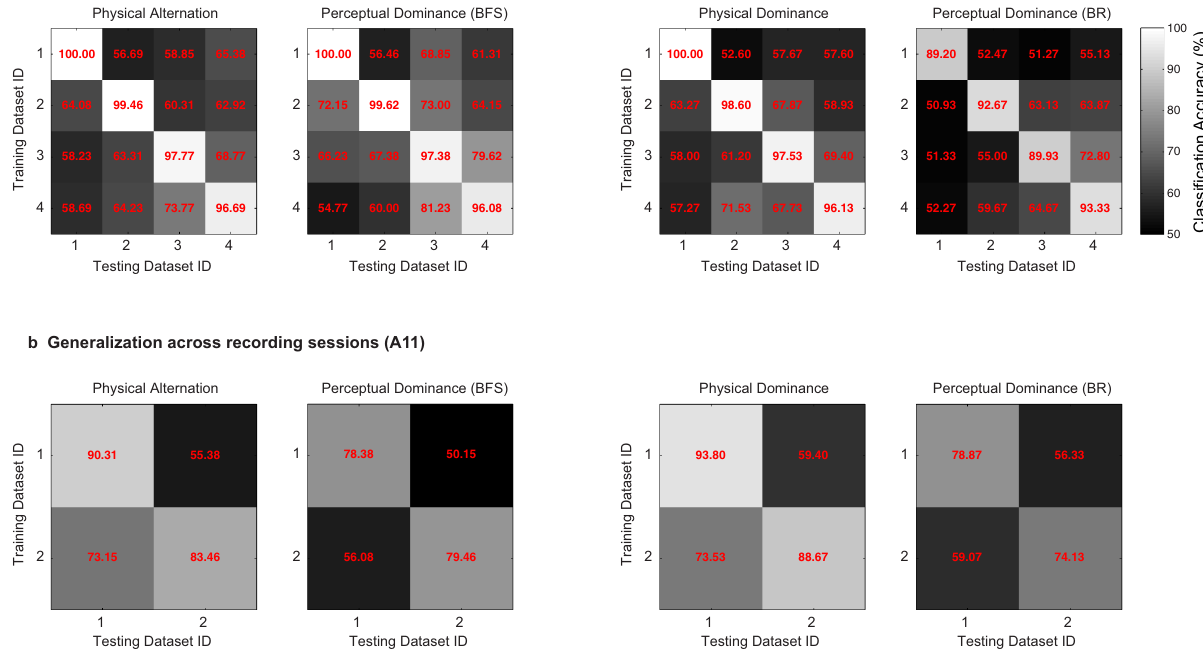
Fig. 5 Decoding within and generalization across recording sessions. Displayed is the classi fi cation accuracy, a , computed for individual datasets and b , generalization accuracy across recording sessions. This analysis requires a correspondence of features across them. The units were identi fi ed after spike sorting, and can therefore be different across individual sessions. Thus, for this analysis, the spiking activity recorded from each of the 96 sites recorded with the array served as features, on which we trained and tested the classi fi er across the recording sessions. Results are presented for both the fl ash suppression (Perceptual dominance - BFS) and the rivalry phase (Perceptual dominance - BR) of the paradigm computed with neural activity elicited during an 800 ms window starting 200 ms after a stimulus or a perceptual change. The main diagonal (upper left to lower right) represents classi fi cation accuracy within a session and lateral diagonals represent generalization accuracy across sessions. While we fi nd on average, high accuracy within individual recording sessions, the generalization across datasets is limited. Moreover, the classi fi cation accuracy within datasets was signi fi cantly more compared to generalization accuracy across datasets (two-sample t- test, two-sided, Physical Alternation within vs. Physical Alternation across , p = 2.42*10 − 9 , Perceptual Dominance (BFS) within vs. Perceptual Dominance (BFS) across , p = 1.94*10 − 5 , Physical Dominance within vs. Physical Dominance across , p = 7.45*10 − 10 , Perceptual Dominance (BR) within vs. Perceptual Dominance (BR) across , p = 1.07*10 − 7 ). Potential reasons for such limited generalization could be that units either change or lose their preference, or it is likely, that we sampled from different units across recording